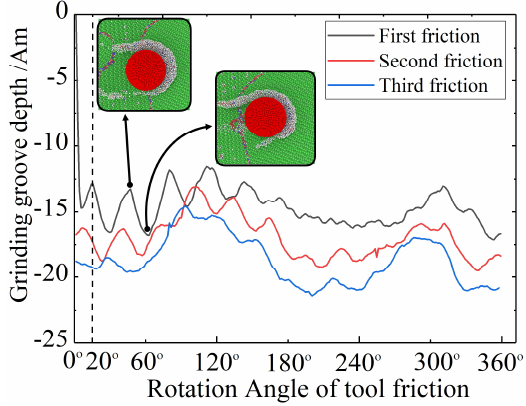
Figure 7. Distance topography of wear marks.